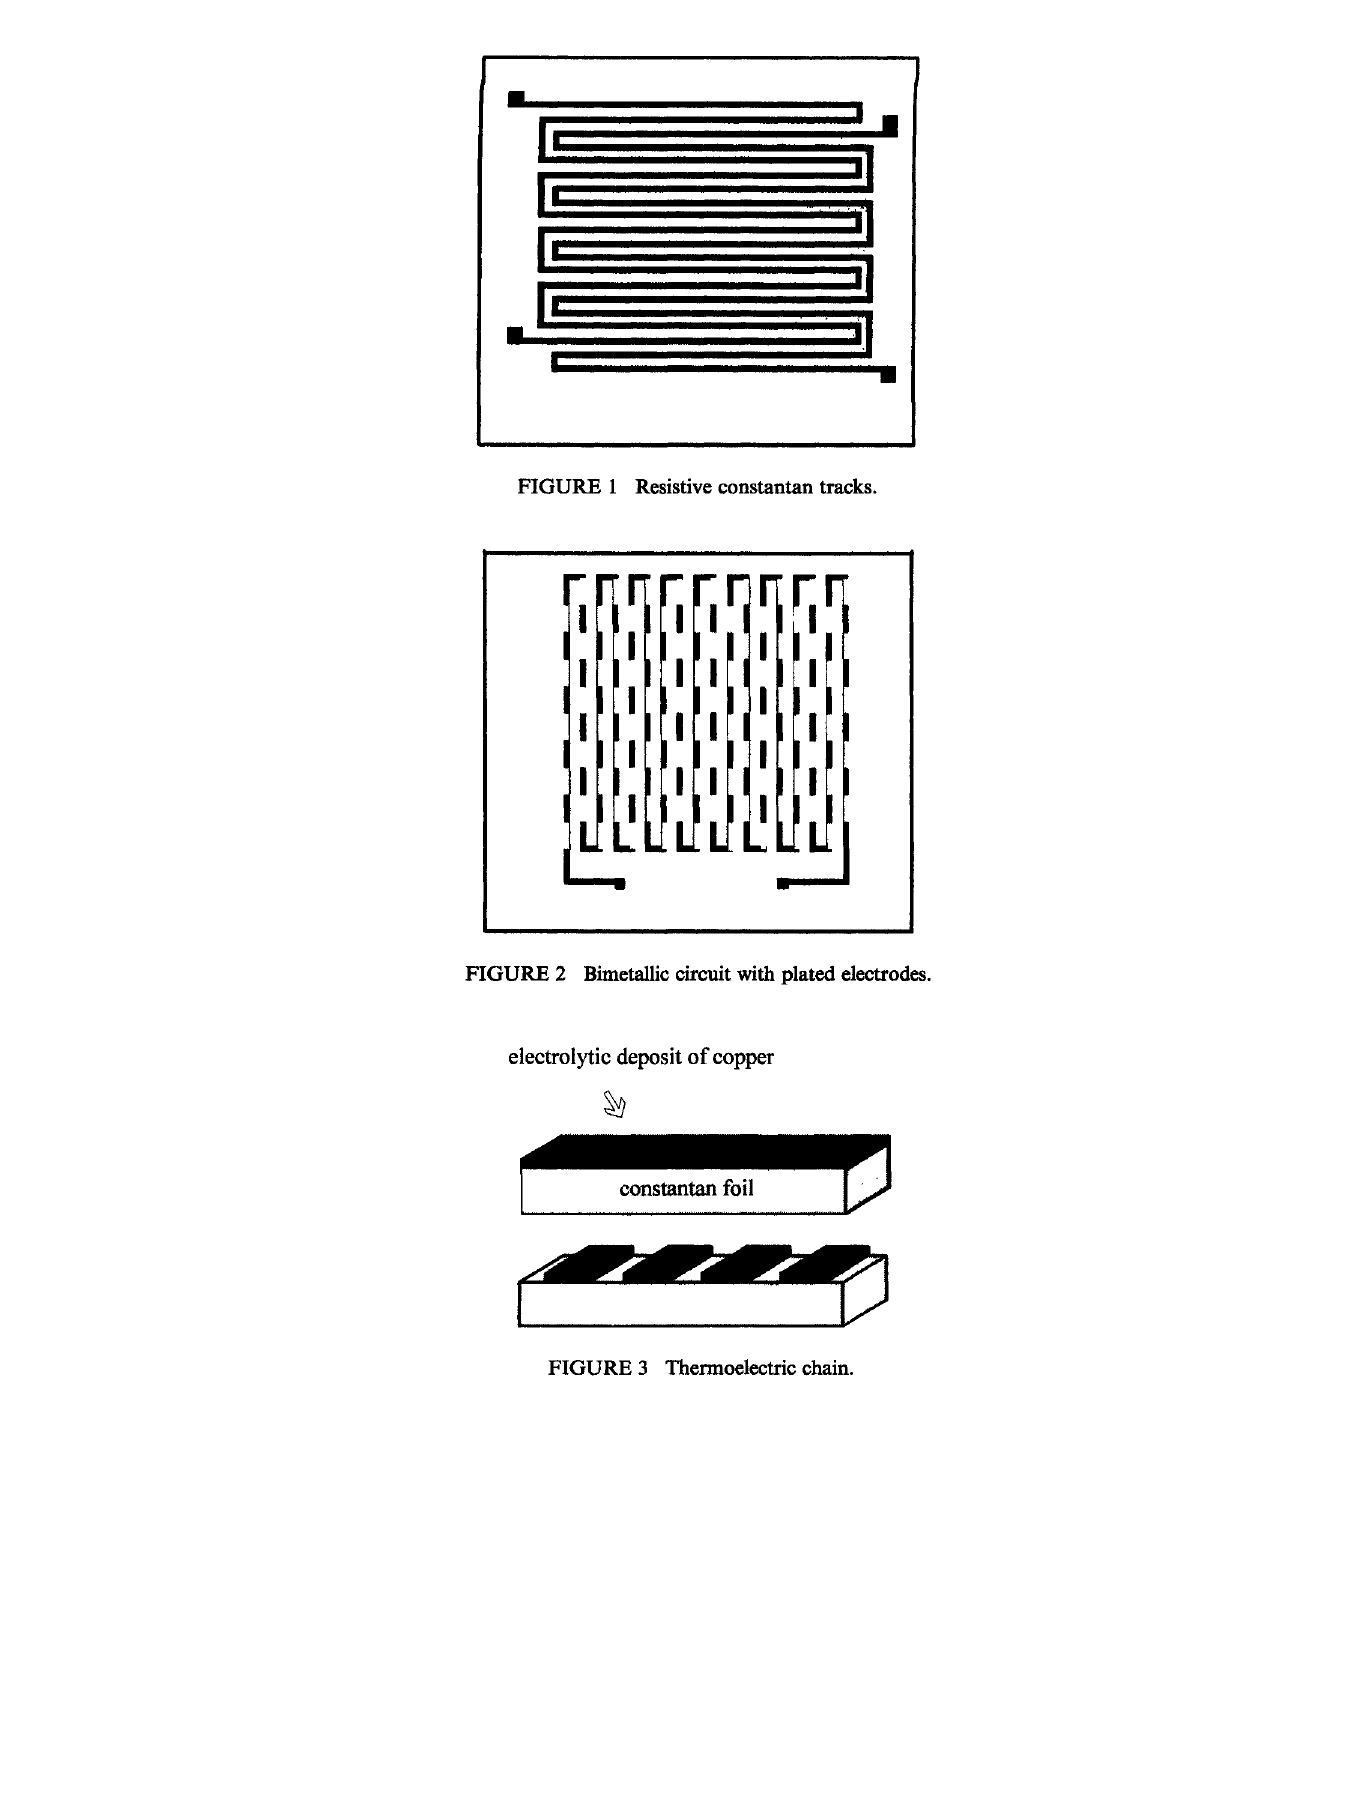
FIGURE 3 Thermoelectric